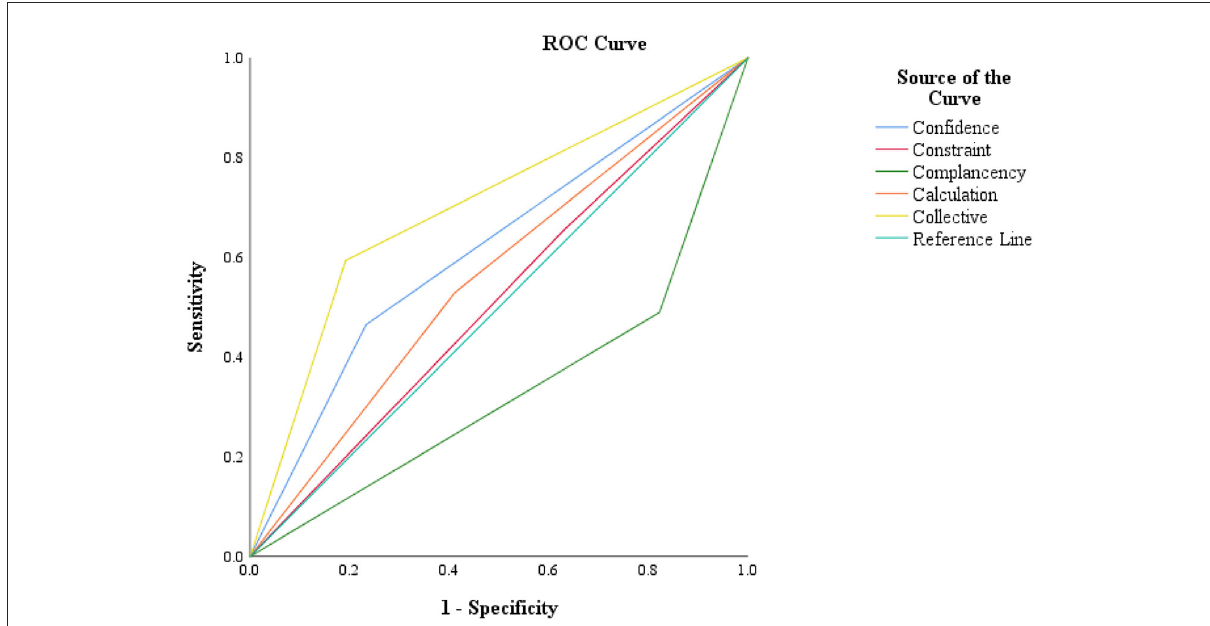
FIGURE5 Receiver operating characteristic (ROC) analysis for 5C subscales in COVID-19 vaccine acceptance